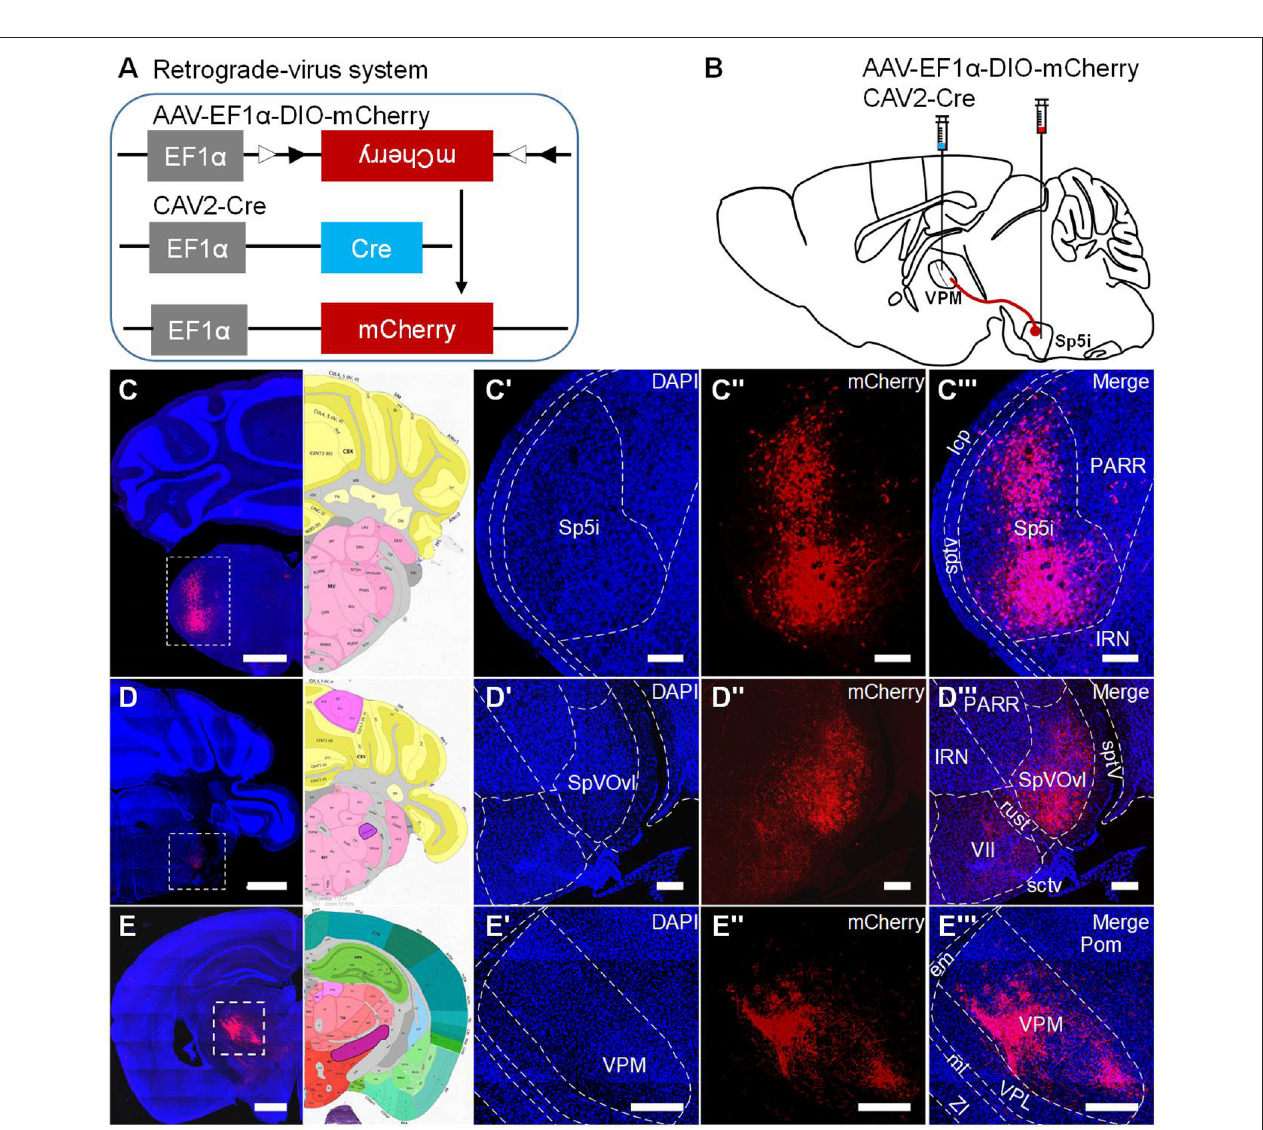
FIGURE 7 | Inputs from Sp5i neurons to VPMdm region. (A) Schematic diagram showing the experimental processes to generate mCherry protein. (B) Virus injection paradigm for labeling Sp5i neurons. The retrograde CAV2-Cre virus was injected into VPM. AAV-EF1 α -DIO-mCherry virus was injected into Sp5i on the contralateral side. (C–C”’) Sp5i neurons were labeled. (C) The coronal section was having infected Sp5i neurons and its corresponding brain map. Amplification of DAPI channel image (C’) and mCherry channel image (C”) and merged channel image with diagram of Sp5i nuclei (C”’) from the white dashed box in (C) . (D–D”’) Sp5i axons project to SpVOvl between Sp5i and Pr5 without neurons infected. (E–E”’) Sp5i axons covering most of VPM region including VPMvl region and VPMdm region. Dashed lines: borders between regions. Scale bars: 1,000 µ m (C–E); 250 µ m (C’–C”’,D’–D”’,E’–E”’) .